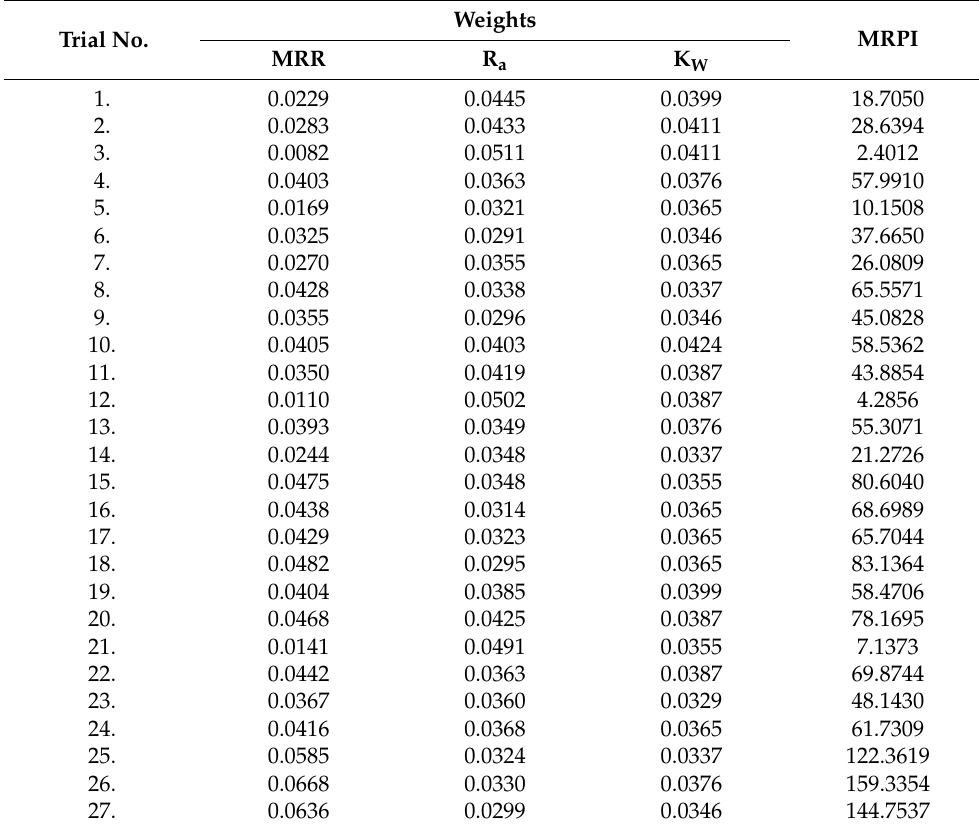
Table 5. Calculation of weights and